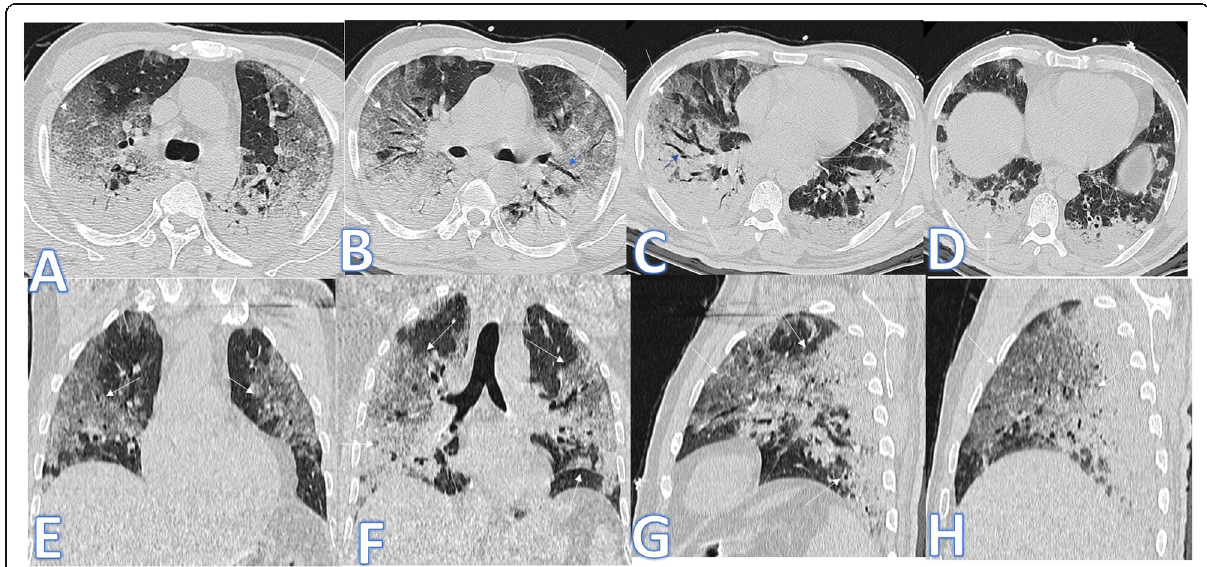
Fig. 4 A 68-year-old male patient with septicemia, presented with fever and cough. CT showed bilateral basal dense consolidations on background of GGO in the anterior non-dependent portions of the lungs and crazy paving appearance (white arrows) with bronchial dilatation in the ground glass opacities (small blue arrows) with no pleural effusion, and the diagnosis was ARDS